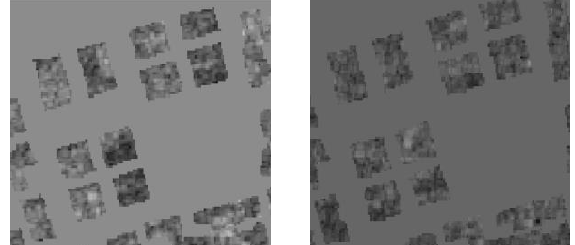
Figure 4. ICEYE SAR images with masked by building vector image (left: pre-EQ ,right: post-EQ).